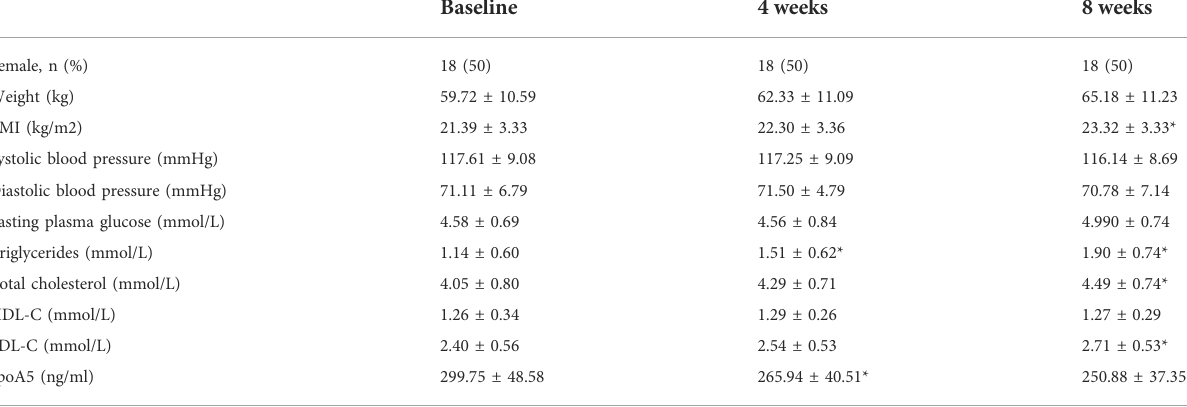
TABLE 2 Clinical and biochemical characteristics of schizophrenia patients receiving olanzapine